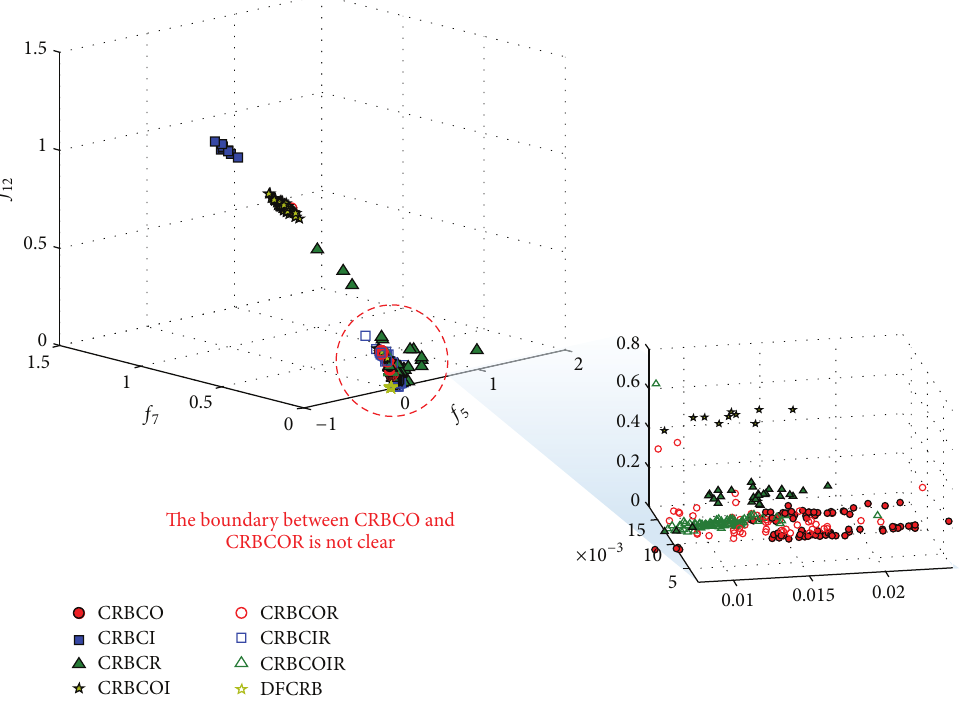
Figure 8: 3-dimensional visualization result of the three fault features in 𝑓 EDET = {𝑓 1 , 𝑓 5 ,𝑓 7 ,𝑓 12 } .